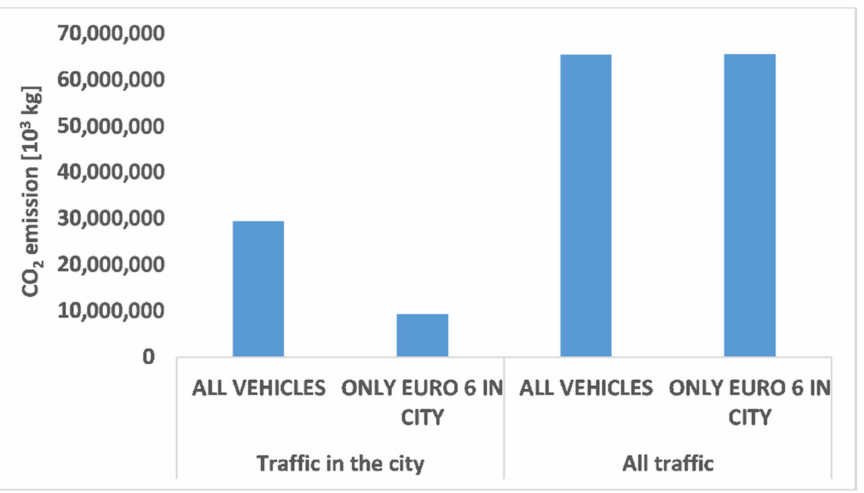
Figure 19. Comparison of CO 2 emissions from all vehicles and Euro 6 vehicles only in an urban area.